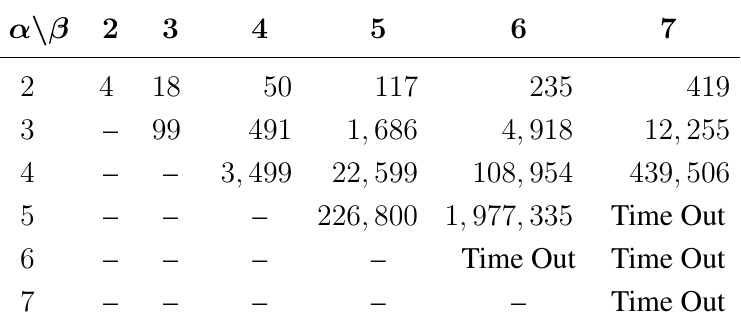
in Numberlink generator for G 1